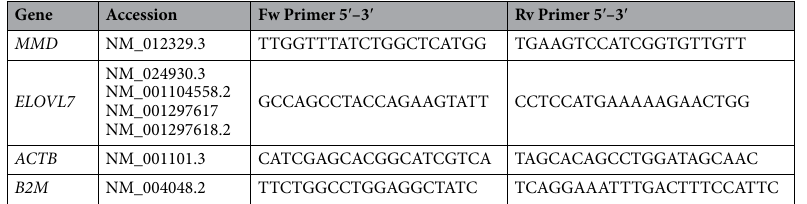
Table 6. Primer sequences and accession numbers of target and reference